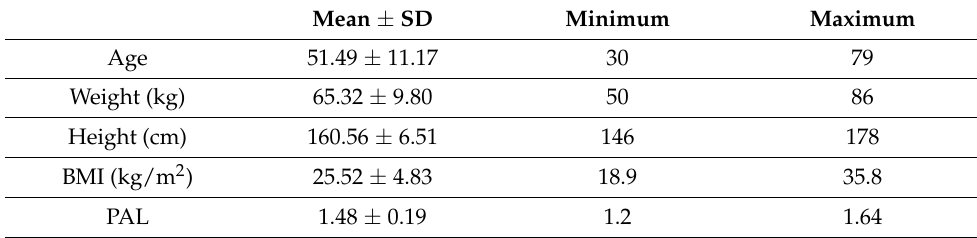
Table 1. Main characteristics of the breast cancer’s